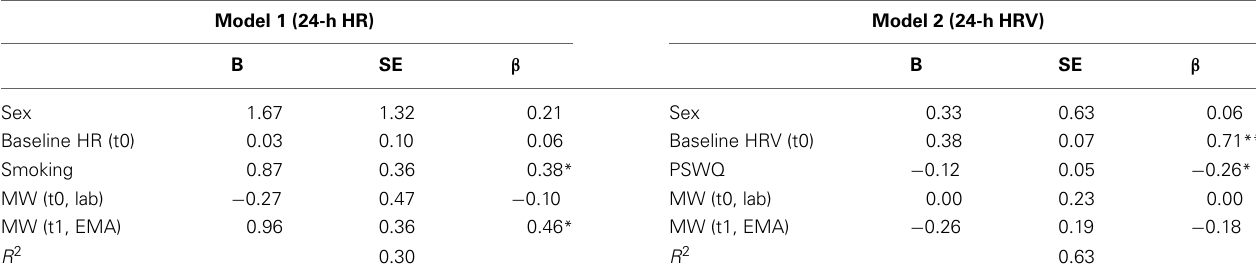
Table 2 | Summary of multiple regression analysis for the prediction of 24-h HR (Model 1) and 24-h HRV (Model 2) at time 1.